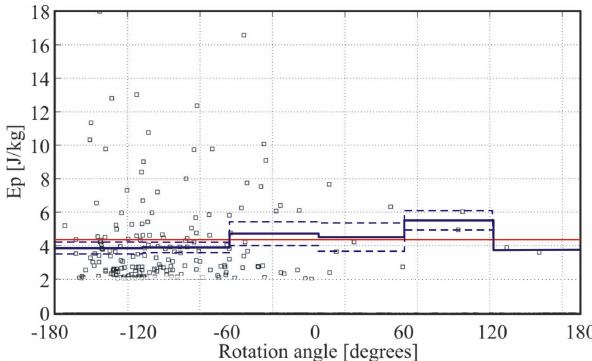
Fig. 5. E p against the most extensive rotation angle of the wind be- tween 1000mb and 50mb for all the studied cases. Solid lines rep- resent the average E p in every 60 ◦ interval after removal of events below the 2J/kg threshold. The vertical interval corresponding to the standard deviation of the mean in each bin is represented by the dashed lines and the total average E p (after removal of the 2J/kg threshold) is given by the red